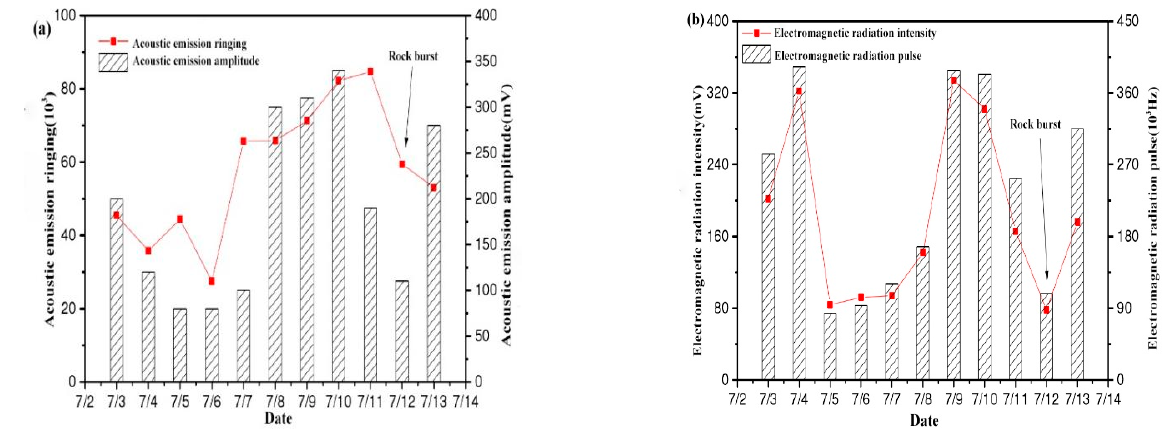
Figure 8. EMR and AE rule of rockburst disaster on 12 July 2014: ( a ) AE ( b ) EMR.